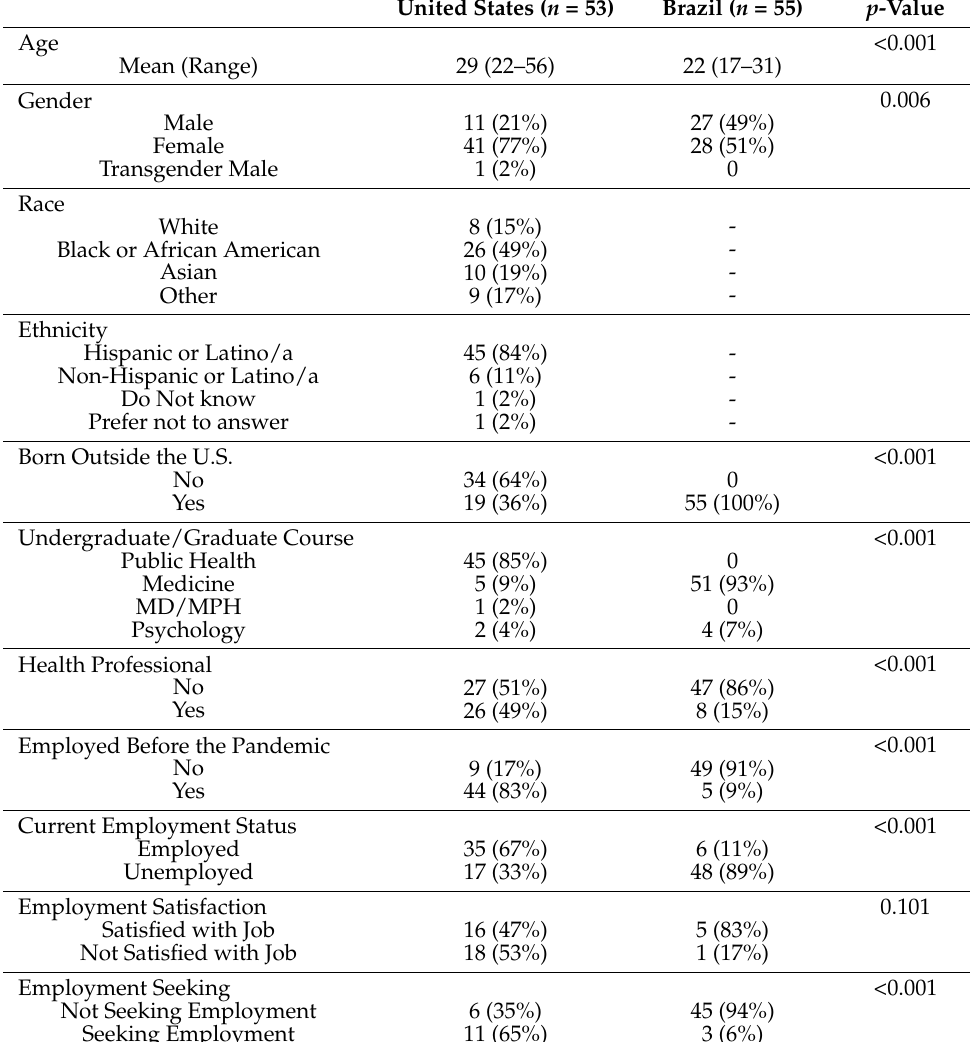
Table 1. Demographics of student